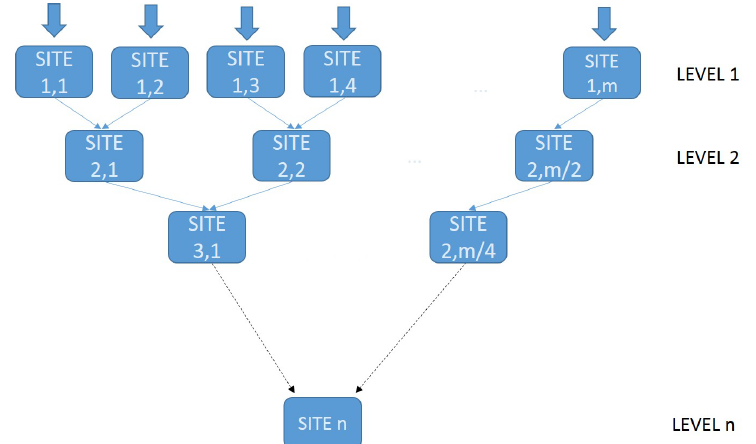
Figure 1. Distributed process. Different populations evolve over different (computational) “sites” independently. Each “site” is locally trained with the GA, and the best chromosomes from the pair of “ascendents” initialize the lower level site